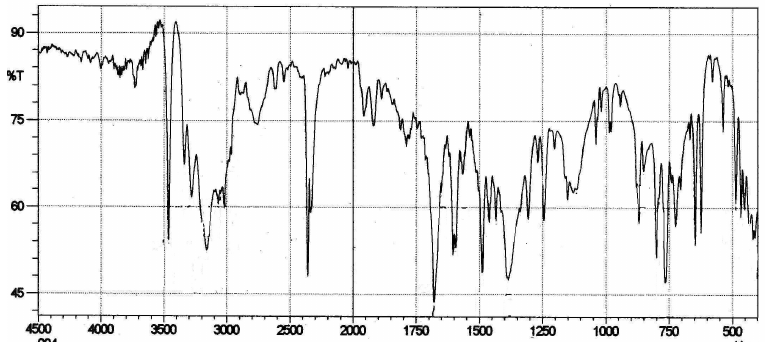
Figure 1 Infrared spectra of 3-(4-amino phenyl)-5-(4-methoxybenzylidene-2-phenyl-3, 5- dihydro-imidazol-4-one) (b)